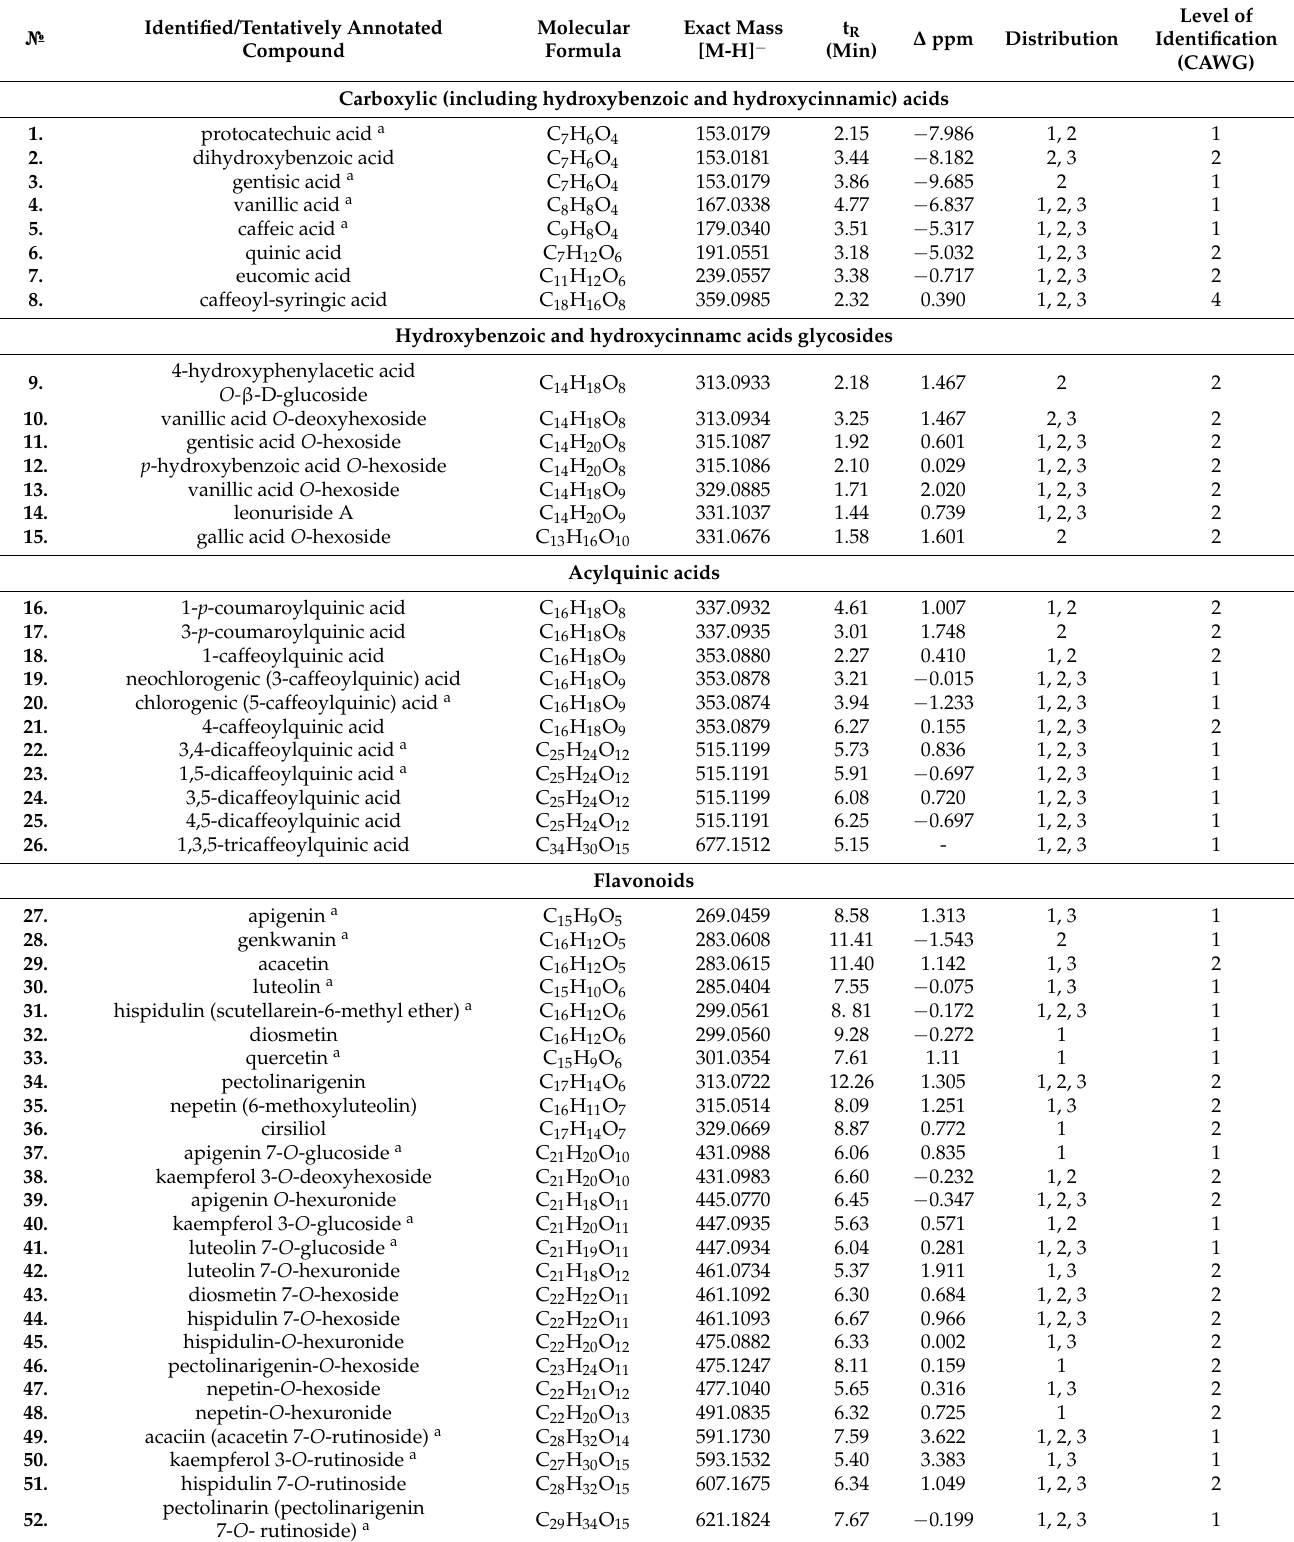
Table 1. Specialized natural products in Cirsium appendiculatum